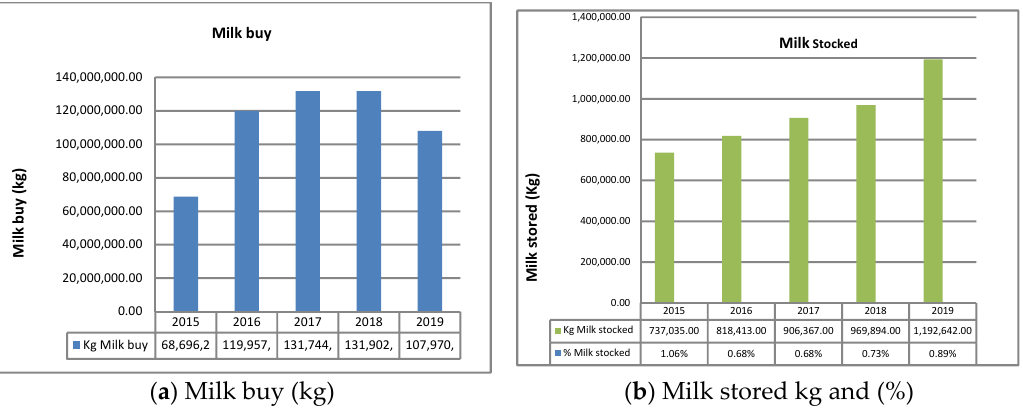
Figure 8. Milk bought ( a ) and milk in non-PDO dairy storage per year ( b ). These data constitute a gap in the system; an agreement is currently being imple- mented between IZSM, SIAN, and DQA to ensure that the freezing plants transmit the data relating to the storage of buffalo milk at their factories in order to accurately track the batches of raw material that should be excluded from processing in the PDO chain